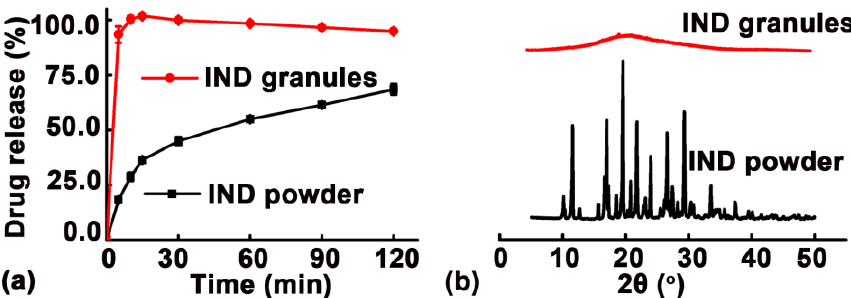
Figure 8. ( a ) In vitro dissolution profiles and ( b ) XRD results of indomethacin (IND) granules prepared via melt centrifugal atomization (MCA) and IND powder.